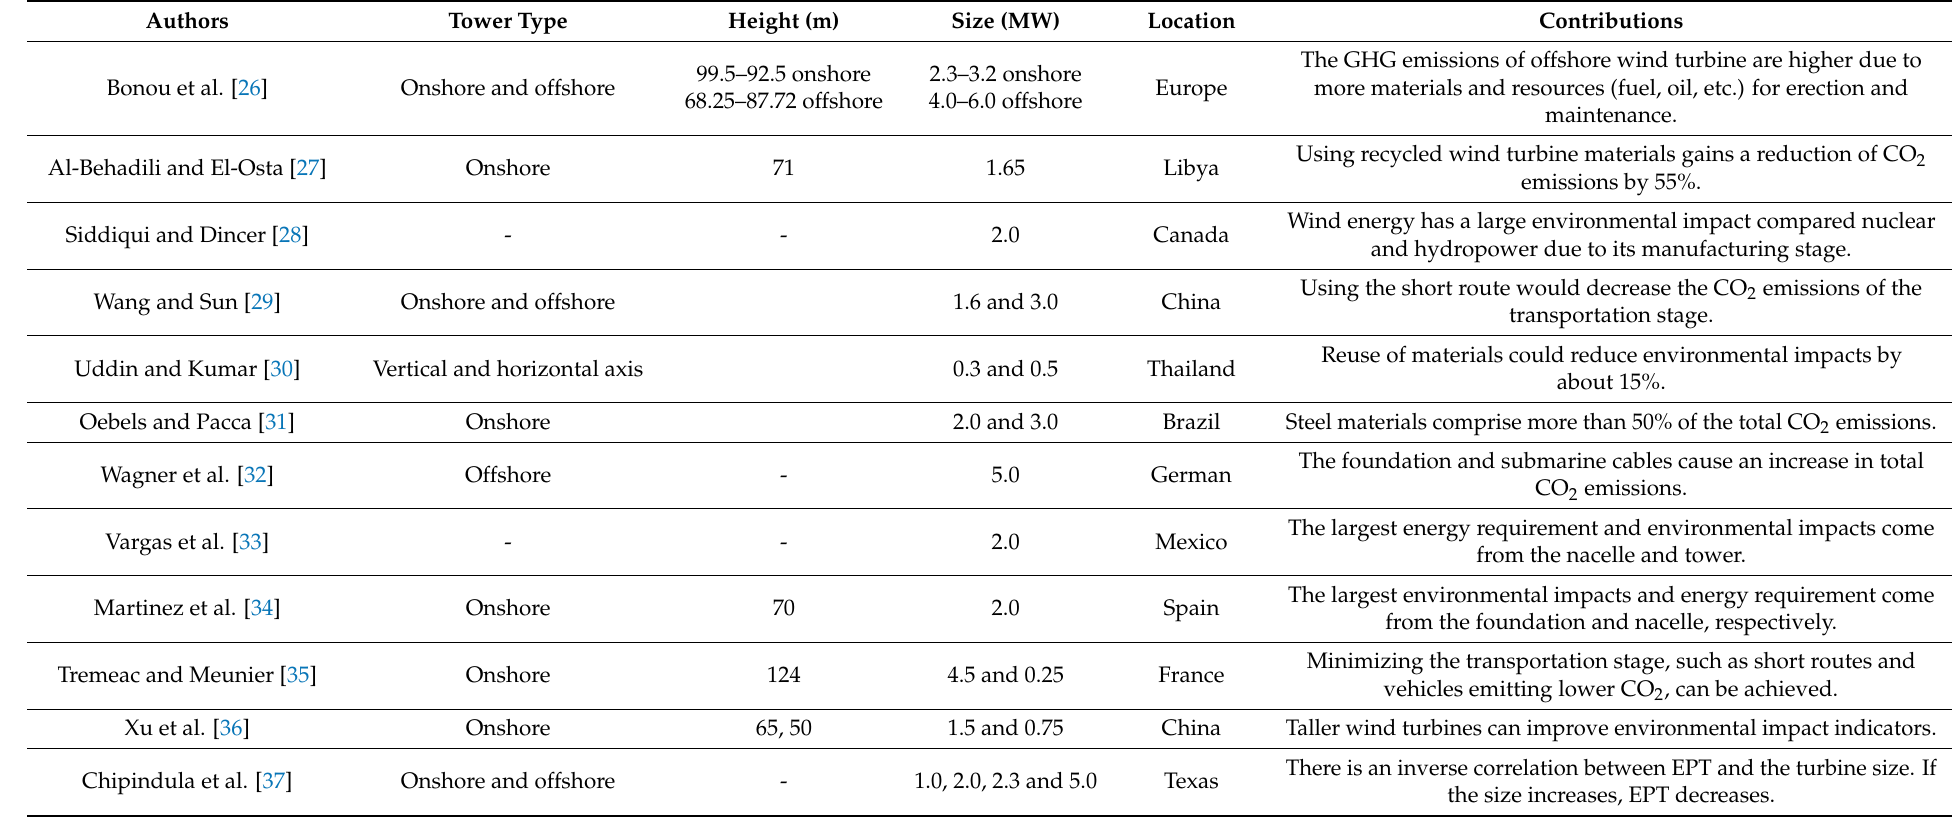
Table 1. Past studies of LCA of onshore and offshore wind turbine